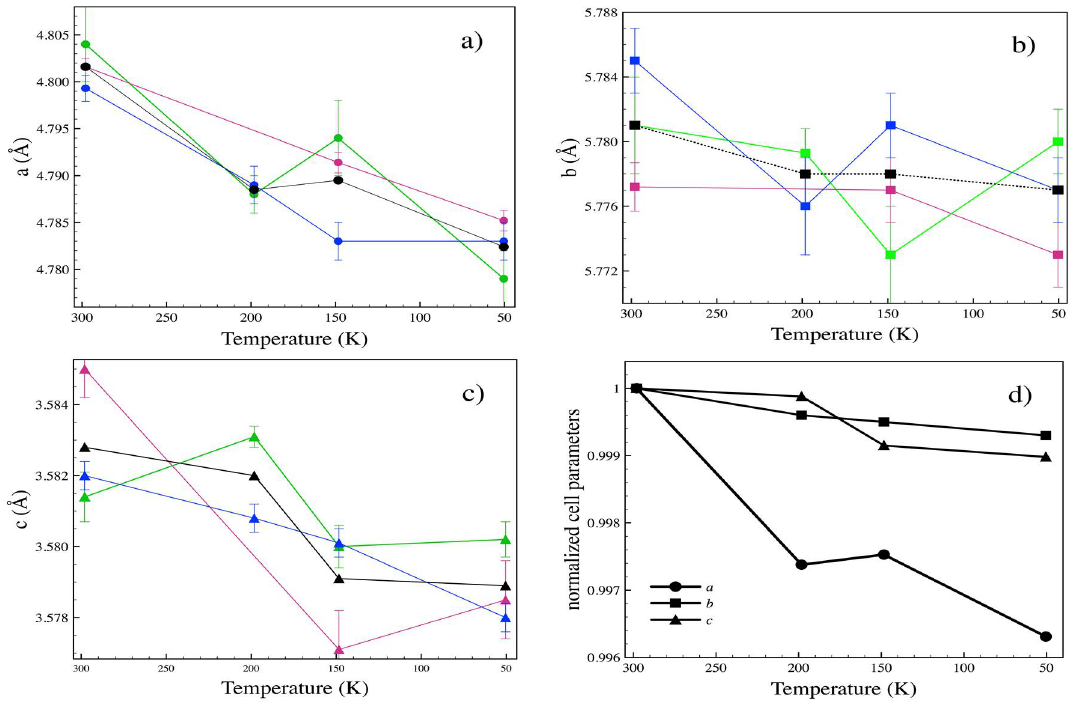
Figure 6. Unit-cell parameters as a function of temperature at ambient pressure. Absolute variations of lattice vectors a , b and c are shown in ( a ), ( b ) and ( c ) respectively; relative variations of the three vectors are shown in ( d ). Red, Blue and green symbols: different crystals in the same sample chamber; black: weighted average of the three crystals.